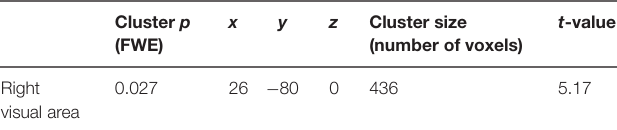
TABLE 2 | Significant activation for the interaction between hand and aversiveness [rubber-hand (aversive – non-aversive) > human-hand (aversive – non-aversive)].